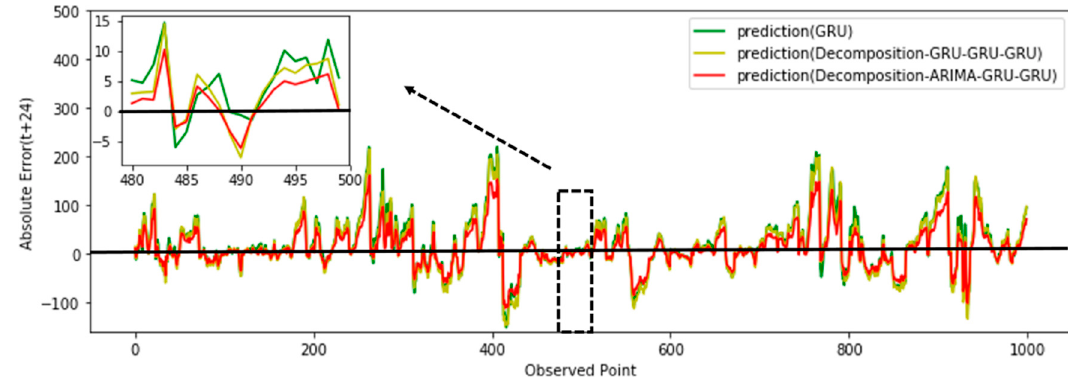
Figure 6. Absolute error between the predicted results and ground truth (24 steps).